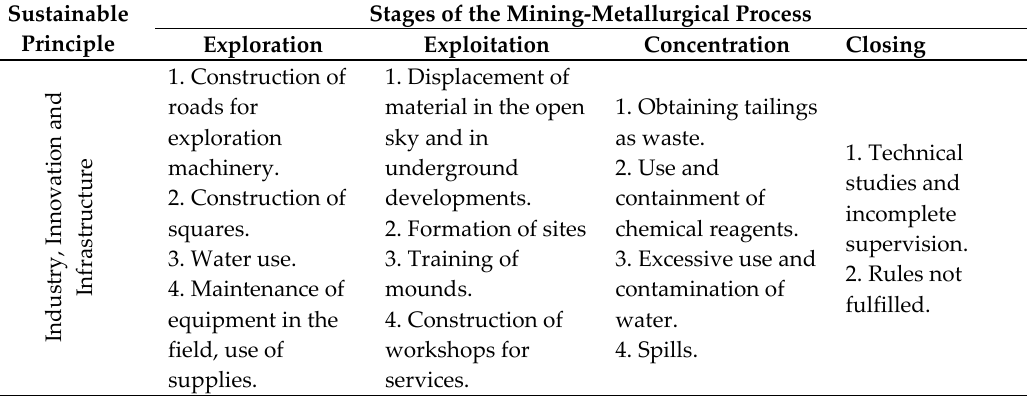
Table 4. Impact risks and environmental impacts categorized by phase of the process and by sustainable principle. Source: own